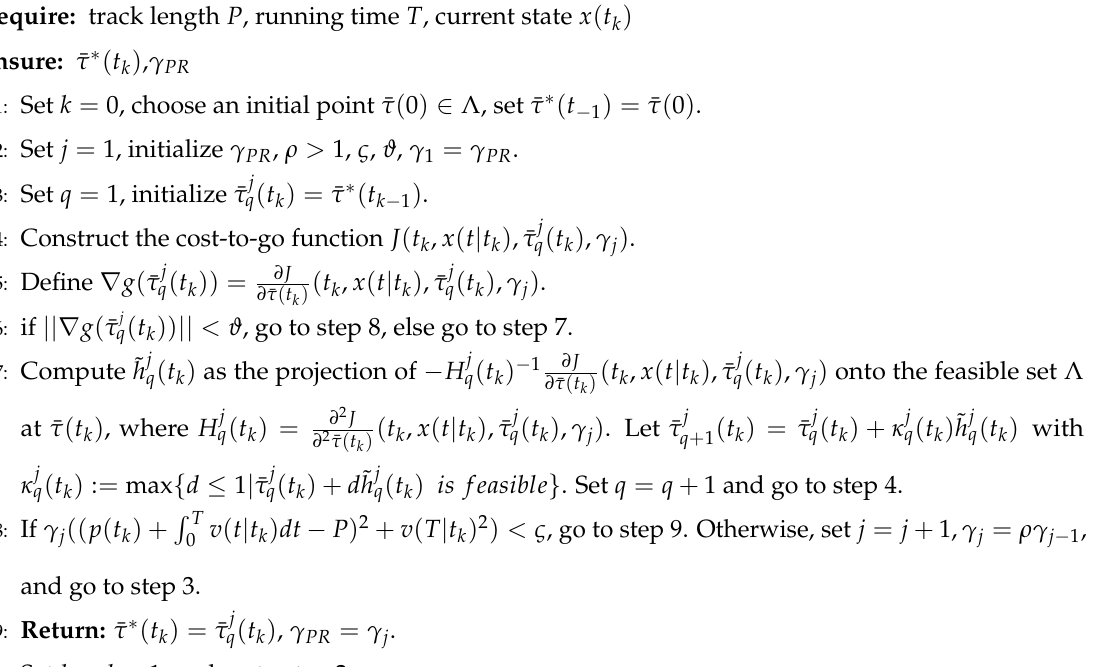
Algorithm 1 Online computation of ¯ τ ∗ ( t k )